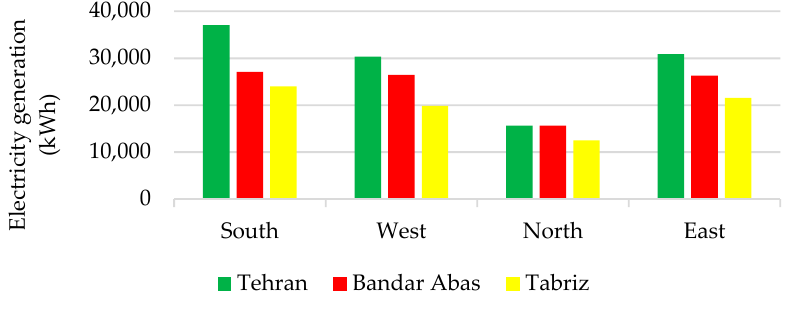
Figure 2. Electricity generation for Poly-Si for different sides.